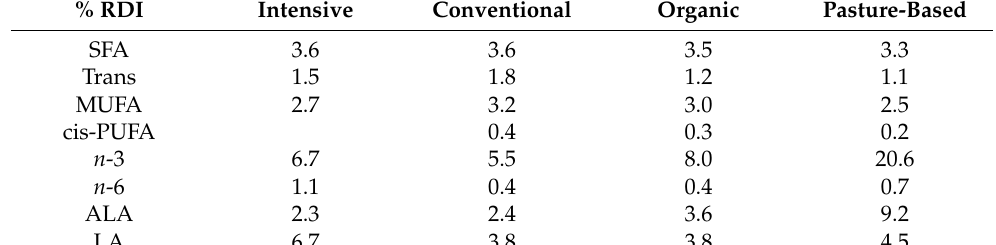
Intensive Conventional Organic